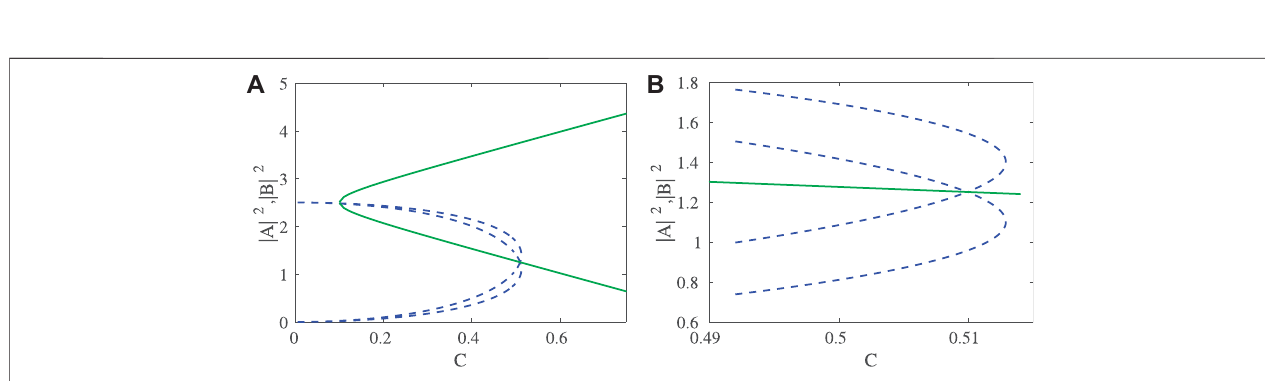
FIGURE 4 | Linear spectra of steady state symmetric solutions from the lower branch. Importantly, in addition to the instability starting at the saddle-node bifurcationwhichgivesrisetoitsexistence,thesolutioninheritsanadditionalinstabilityatabifurcationpointof C =0.51.Therestoftheparametersarethesameasinthe previous Figures.